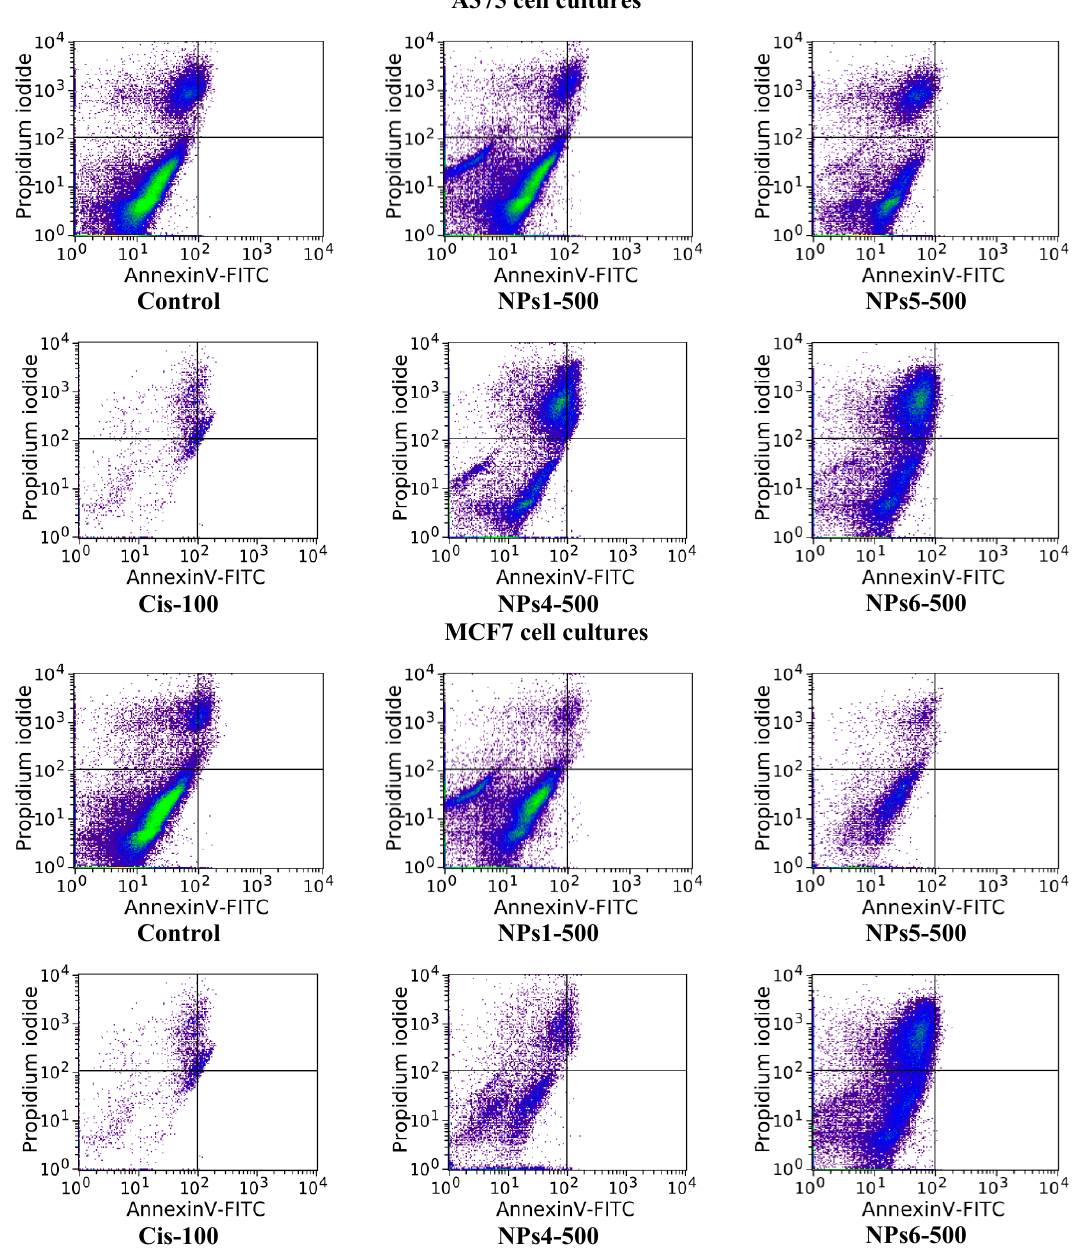
Figure 5. Effect of the 48 h treatment, at a concentration of 500 μ g/mL of all the NP samples and Cis on the frequency distribution of viable (Q1), dead (Q2), apoptotic (Q3), and preapoptotic (Q4) cells corresponding to each group in the case of A375 and MCF7 neoplastic cell cultures.